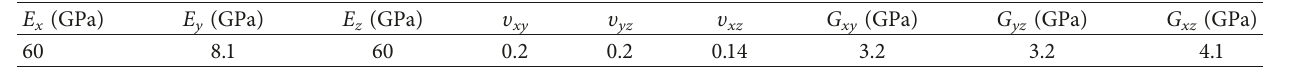
Table 1: Elastic mechanical properties of the composite